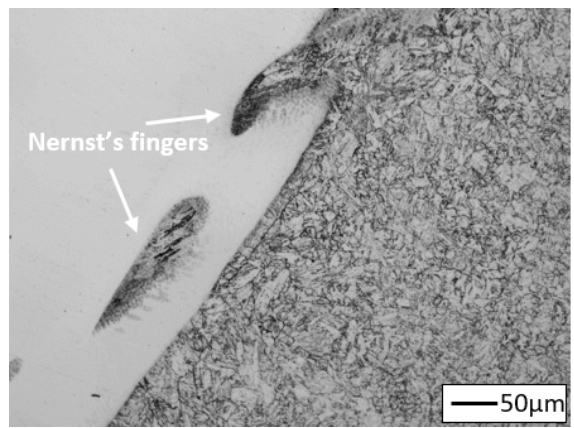
Figure 10. Nernst’s fingers in the weld of joint No. 2.